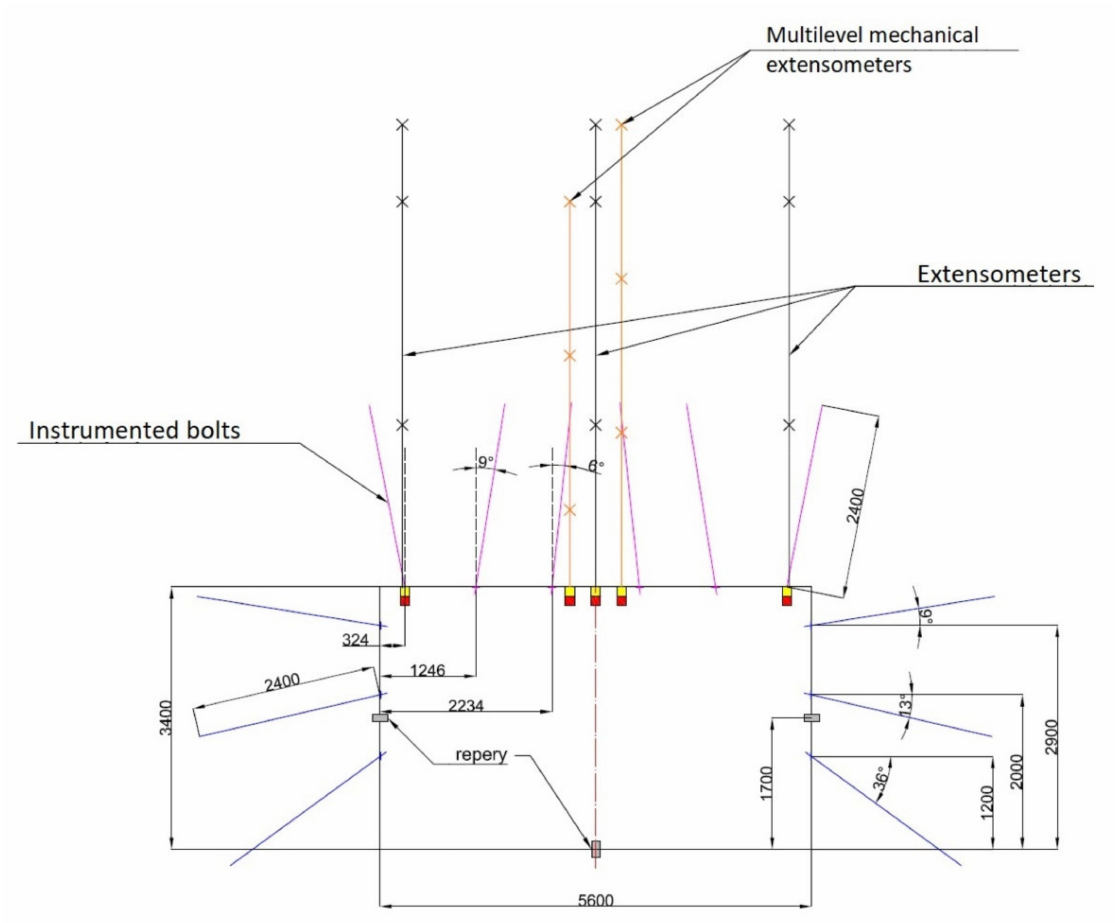
Figure 1. A scheme of periodic control station no. 2 vertical cross section.